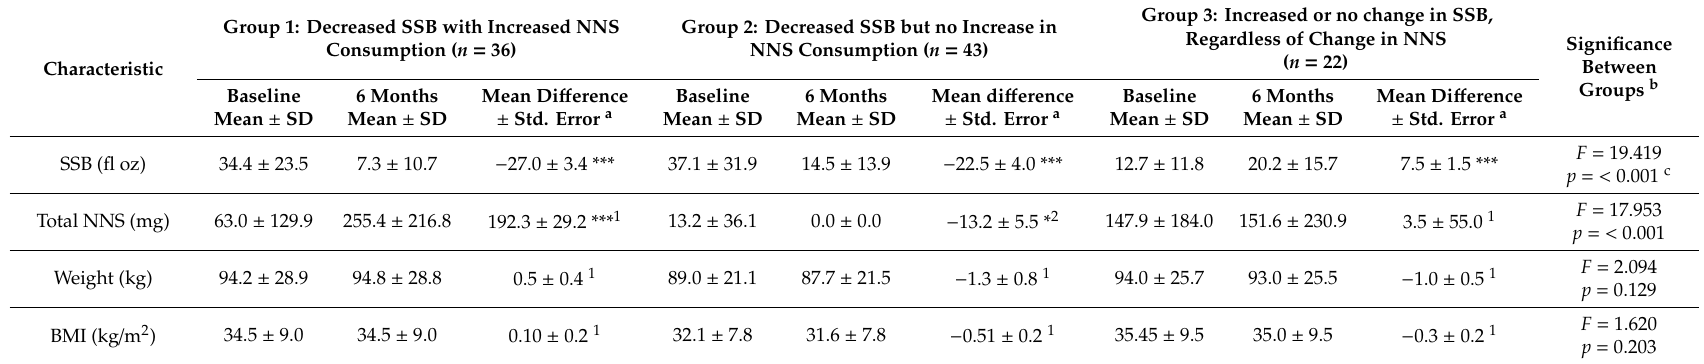
Table 5. Di ff erences in mean daily sugar-sweetened beverage (SSB) and non-nutritive sweetener (NNS) consumption, body weight, and body mass index between SSB-NNS consumption change groups over